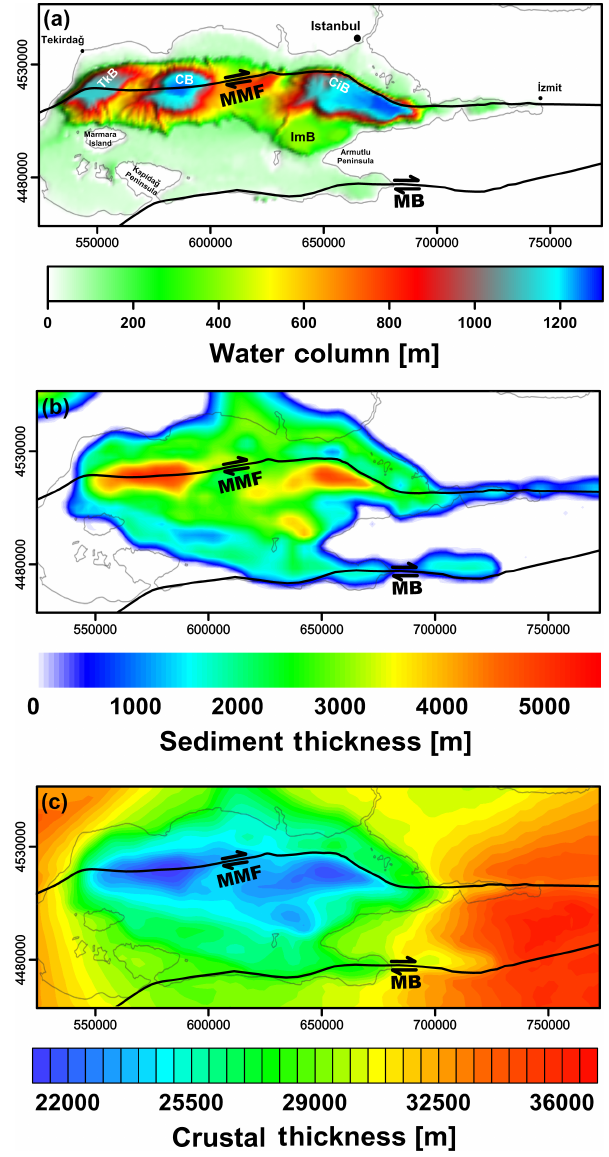
Figure 3. Thickness distribution map of the initial structural model (WGS84, UTM zone 35 ◦ N); (a) seawater column, (b) syn- kinematic sediment thickness, and (c) homogeneous crustal thick- ness. Abbreviations: main Marmara fault (MMF), middle branch of NAF (MB), Çınarcık basin (CiB), Central basin (CB), Tekirda ˘ g basin (TkB), and Imralı basin